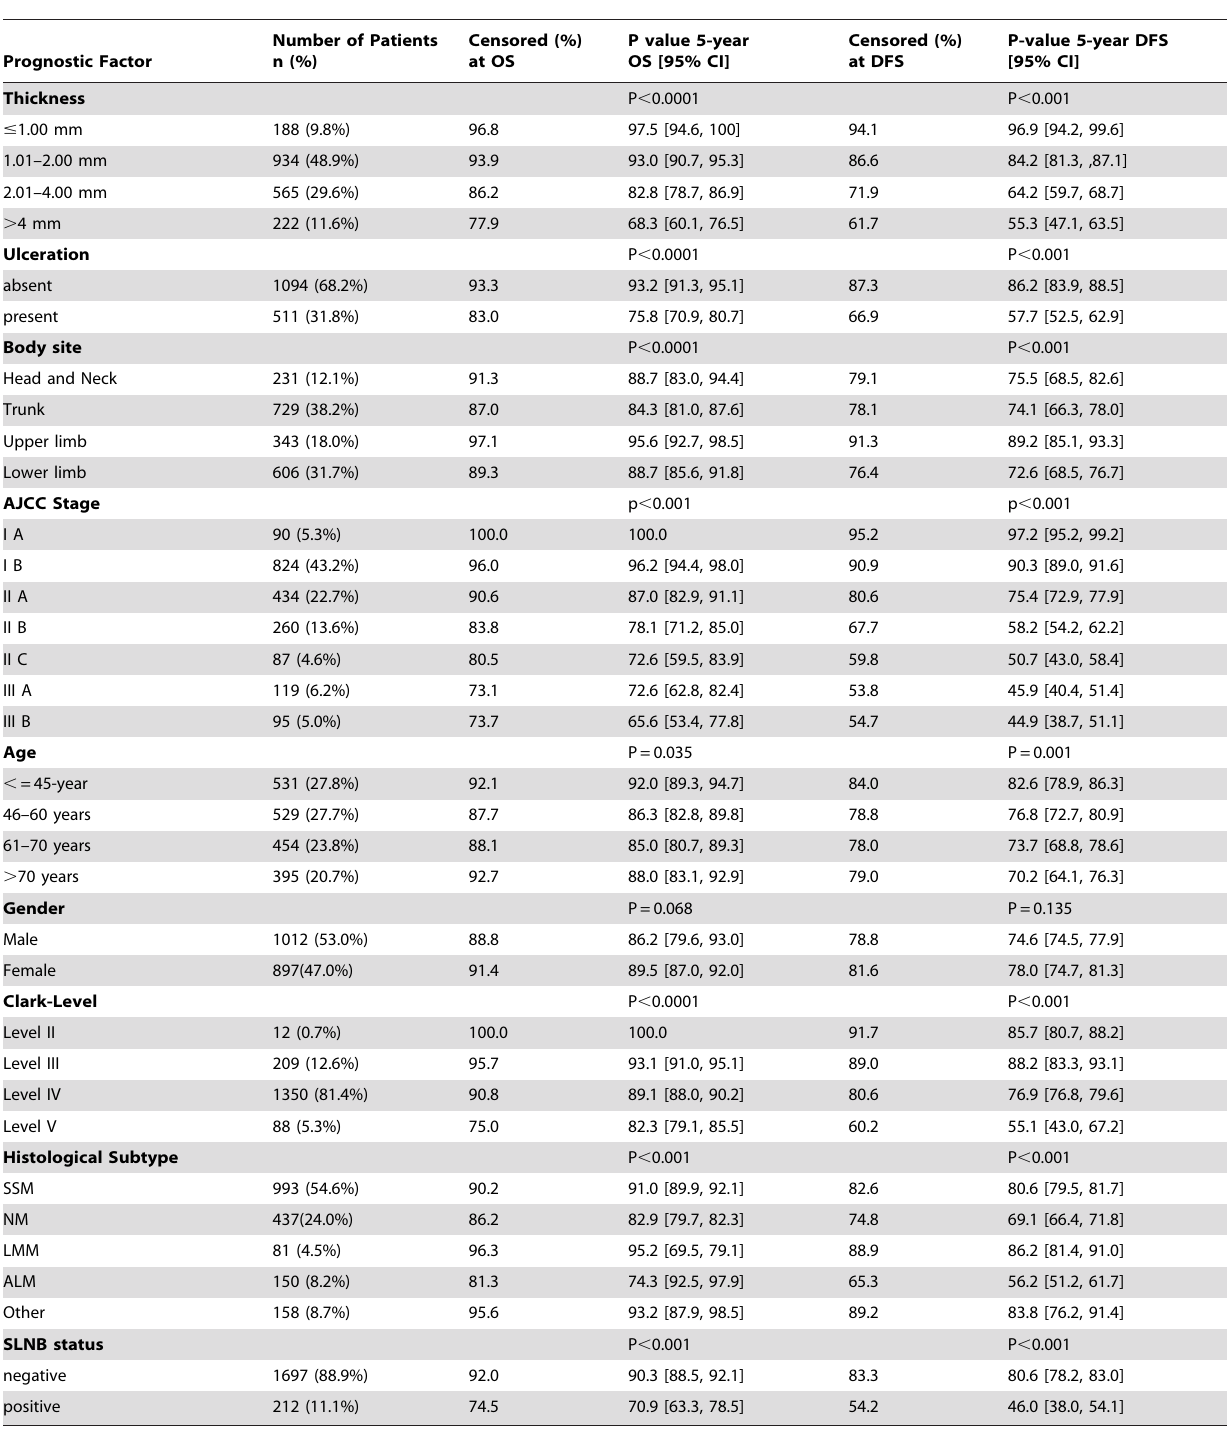
Table 1. Five-year overall survival (OS) and disease-free survival (DFS) probabilities based on Kaplan-Meier in sentinel node staged patients with CM